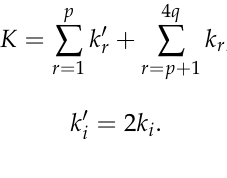
Figure 5. Three columns constrained by a connecting plate.